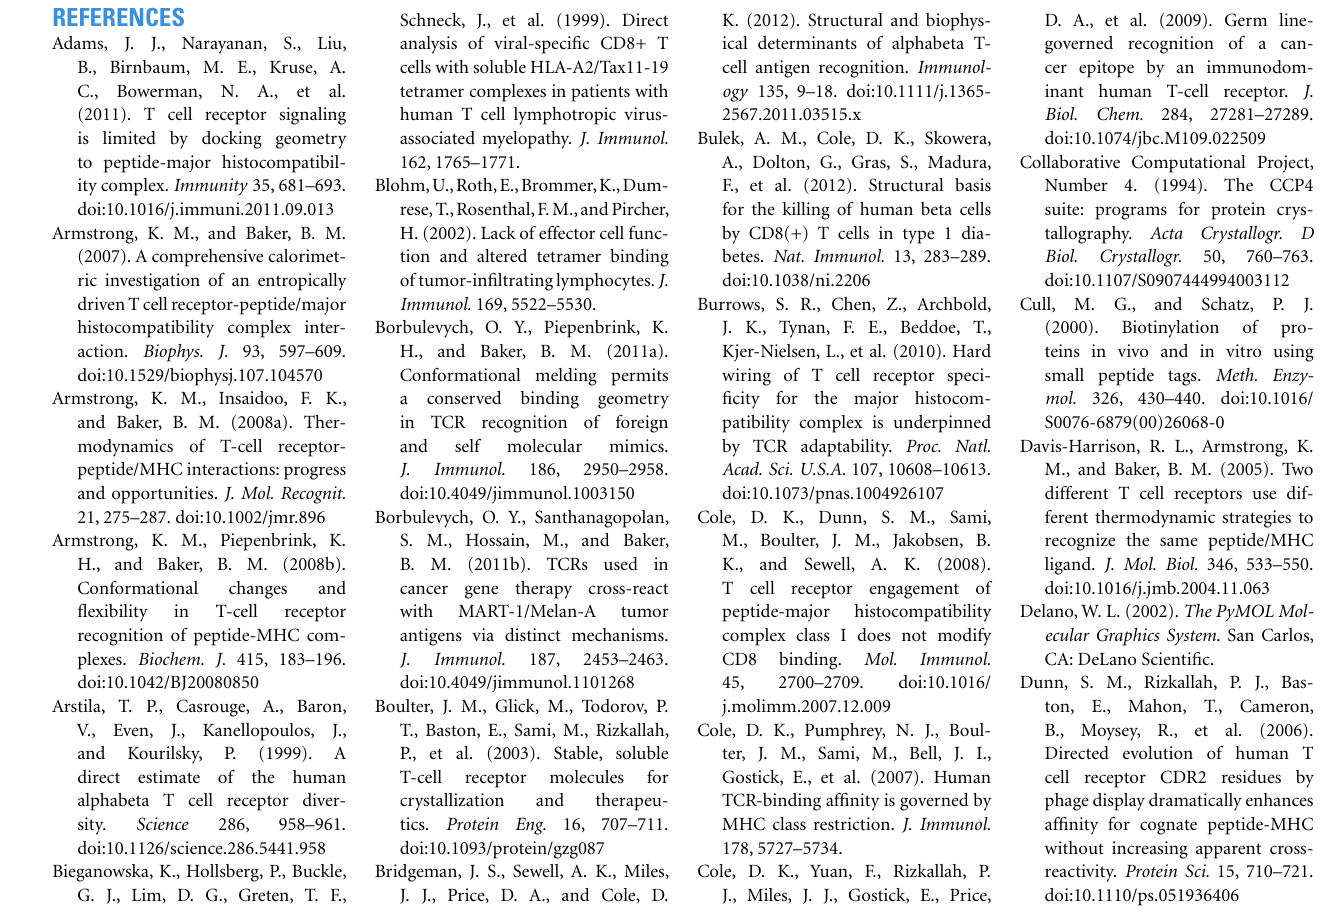
Table S1 | Data collection and refinement statistics (molecular replacement). Table S2 | Structural analysis ofA6wt/A2-Tax contacts. Table S3 | Structural analysis forA6c134/A2-Tax contacts (mutant residues in